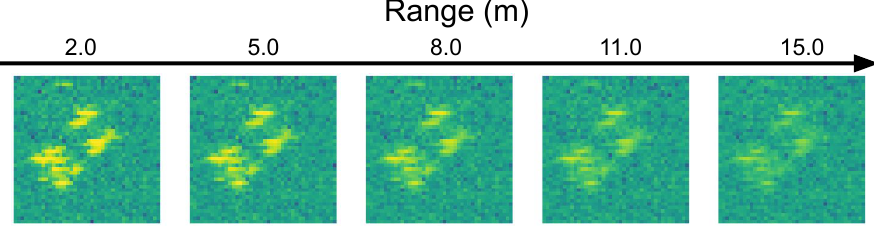
Figure 5. Range data augmented images for the trolley at 2–15 m.